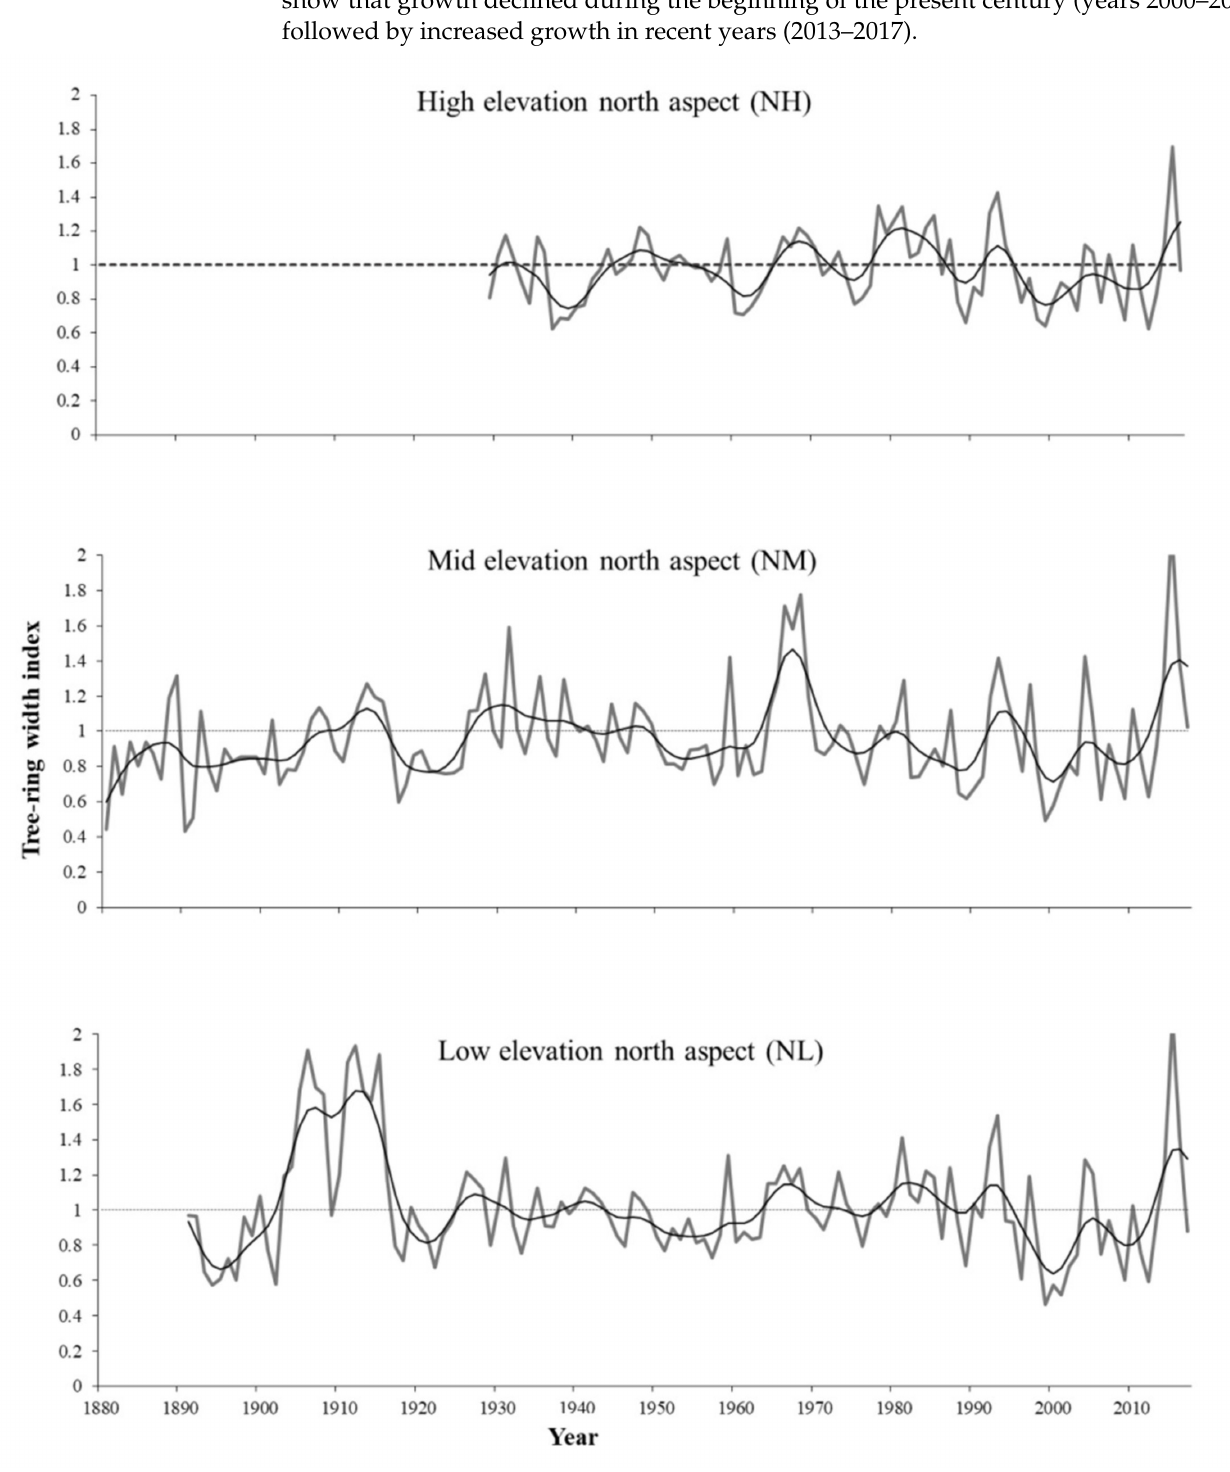
Figure 3. Ring-width chronologies of A. jaliscana in the north aspect of the mountains in western Jalisco, Mexico. The gray line corresponds to the annual ring-width indices; the flexible line is a decadal spline to highlight low-frequency events, and the dotted line is the mean of the ring- width